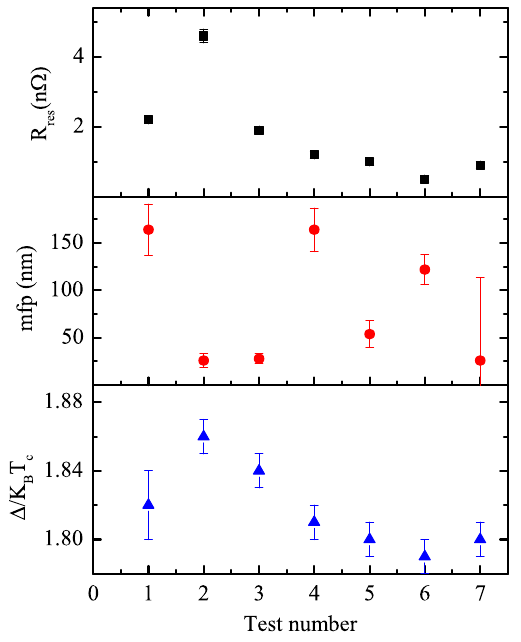
FIG. 2. Material parameters obtained from the fit of R s ð T Þ from 4.3 to ∼ 1 . 5 K. The error bars on some R size of the